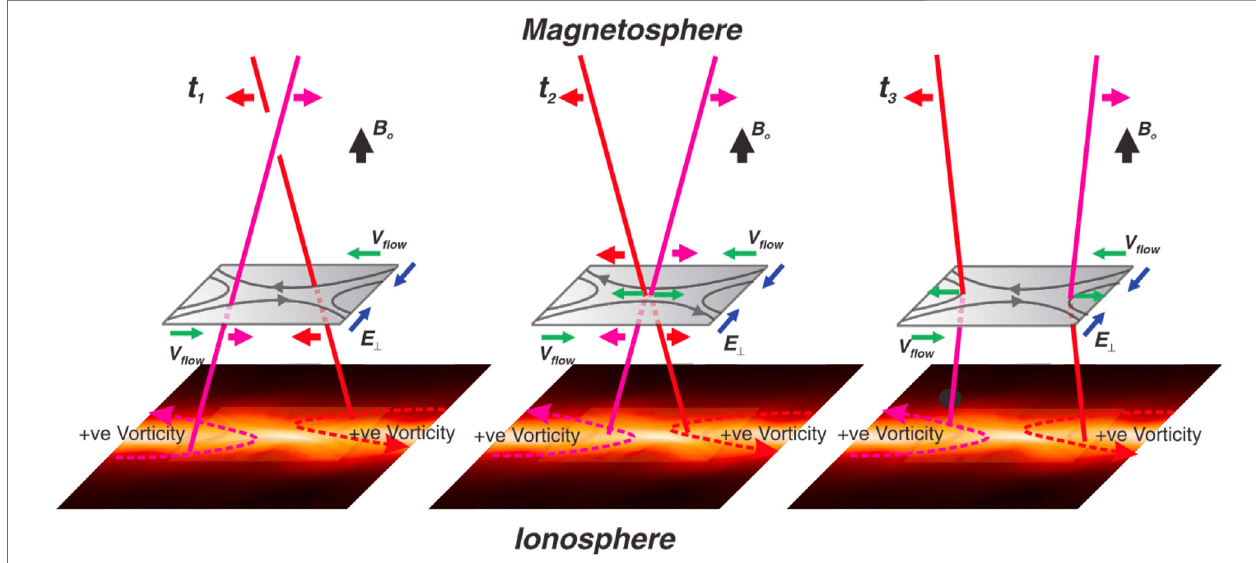
FIGURE 4 | Schematic of extreme guide fi eld reconnection and its relation to discrete auroral arc structure (Chaston et al., 2015). Reconnection involves the horizontal magnetic fi eld components.